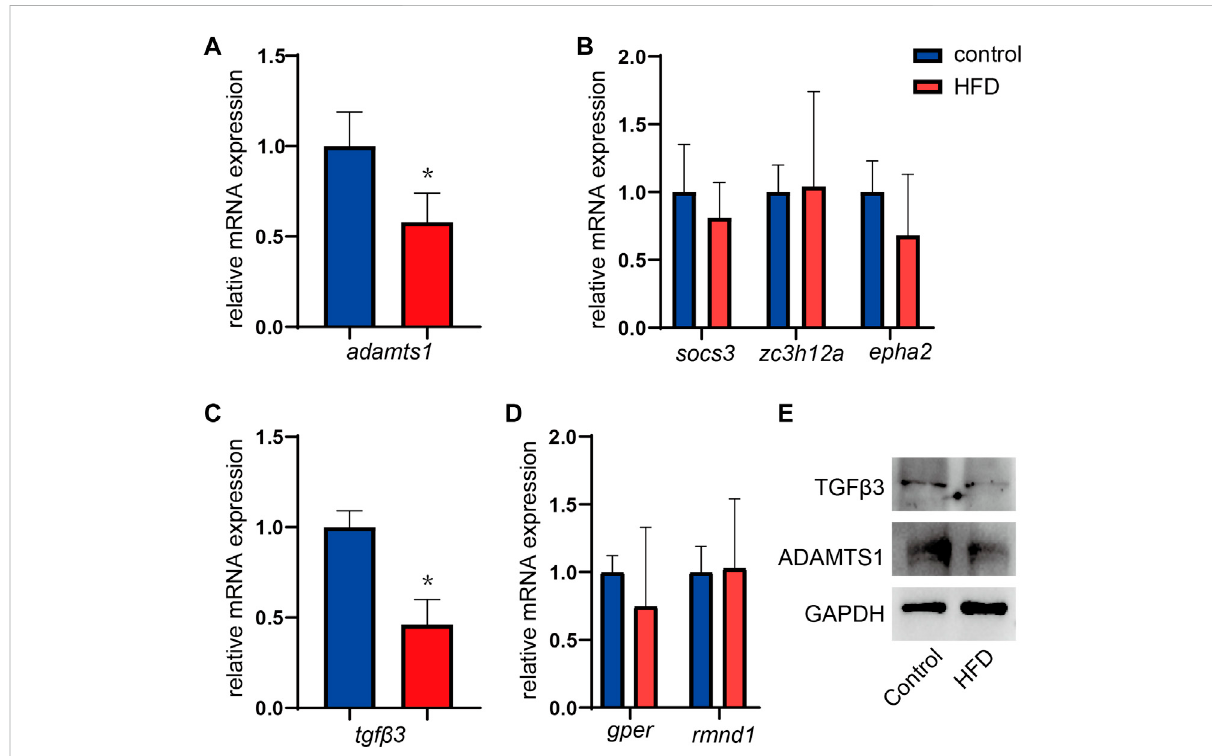
FIGURE 8 (A,B) Expression of the hub genes in the brown modules. n = 5. (C,D) Expression of the hub genes in the yellow modules. Results represent the mean ± SD of fi ve to six independent experiments. n = 5. (E) One representative western blot of three independent western blot experiments is shown. Data are mean ± SD.* p < 0.05 versus CD